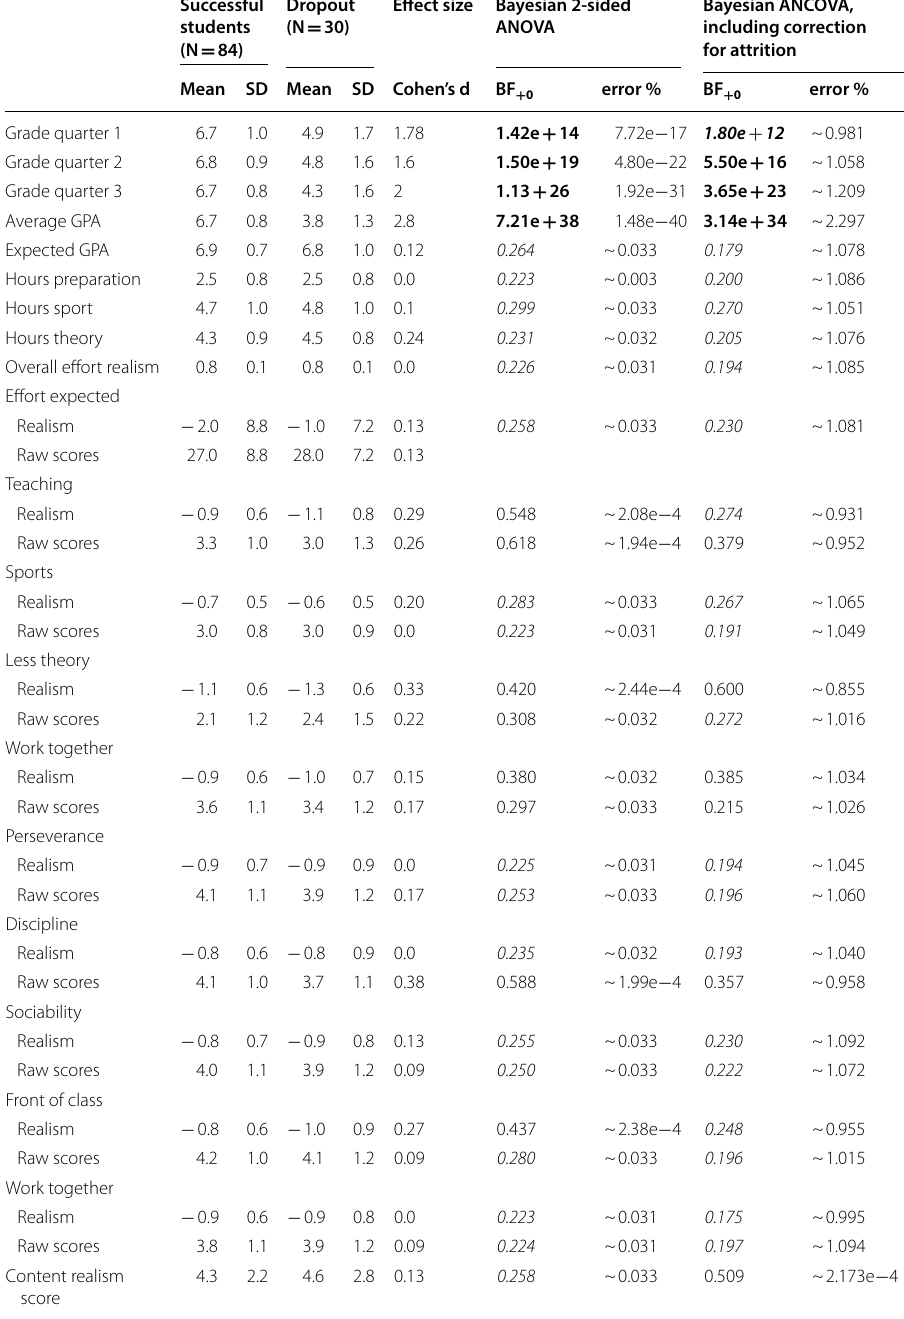
Table 6 Grades and responses to the expectations questionnaire after one year or at the moment of dropping